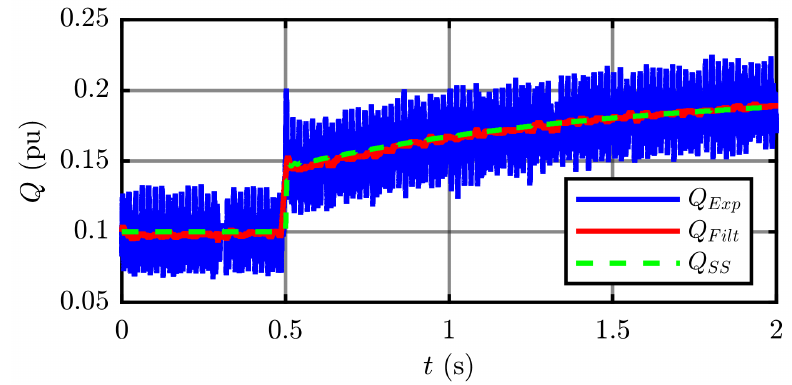
from 0.1 pu to 0.2 pu. Reactive power injected ext